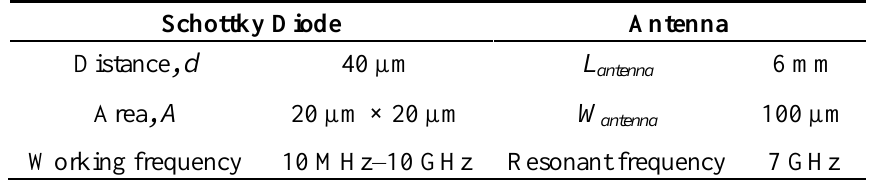
Table 1. Device dimensions and operating frequencies of the Schottky diode and